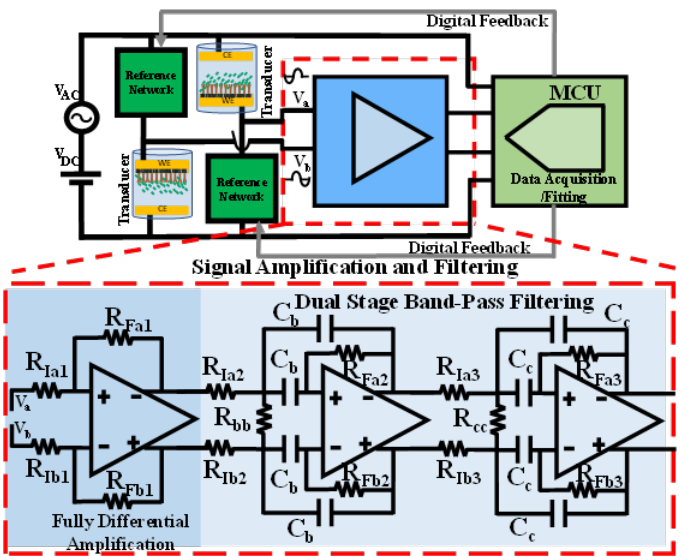
Figure 2. The three-stage amplification and filtering unit, proceeding the differential sensing unit and succeeding the data acquisition and fitting unit. A fully differential amplification followed by a cascaded two-stage bandpass filter provides the differential gain and filters the unwanted noise for certain minimum SNR. It is critical to maintain good matching in the feedback ratios of the peripheral components, as shown in (3), to achieve the overall target CMRR.